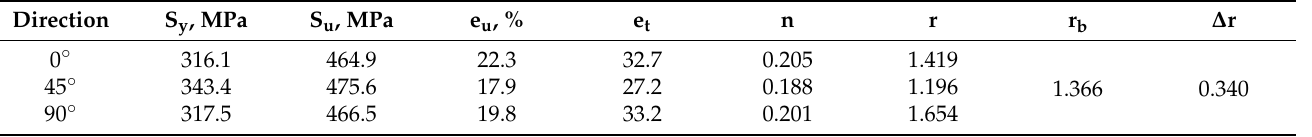
Table 2. Mechanical properties of the AISI 430